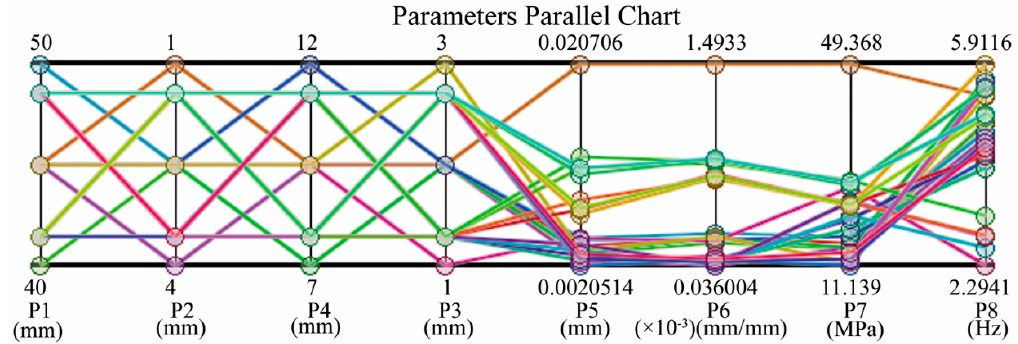
Figure 5. Parameters chart of SDO: design points with different colors generated via varied combination of the input parameters.